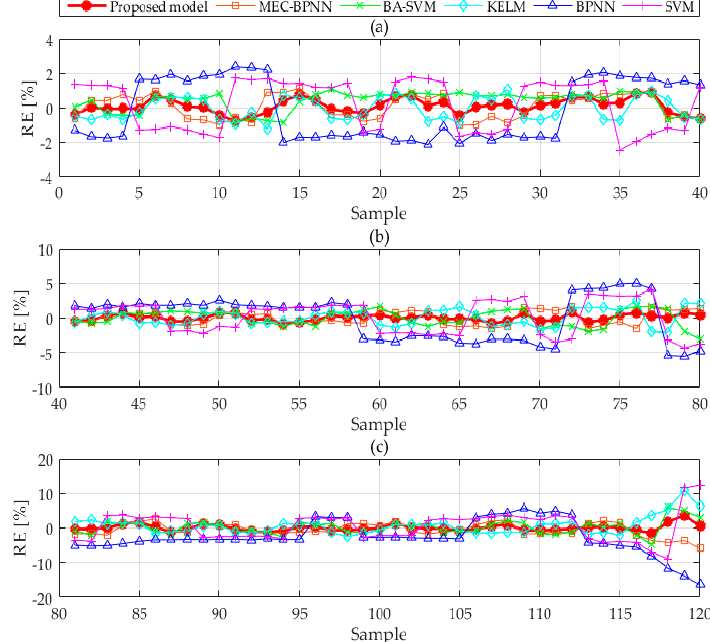
Figure 9. The relative errors curve of each method: ( a ) the relative error from 1 to 40 sample point; ( b ) the relative error from 41 to 80 sample point; ( c ) the relative error from 81 to 120 sample point.